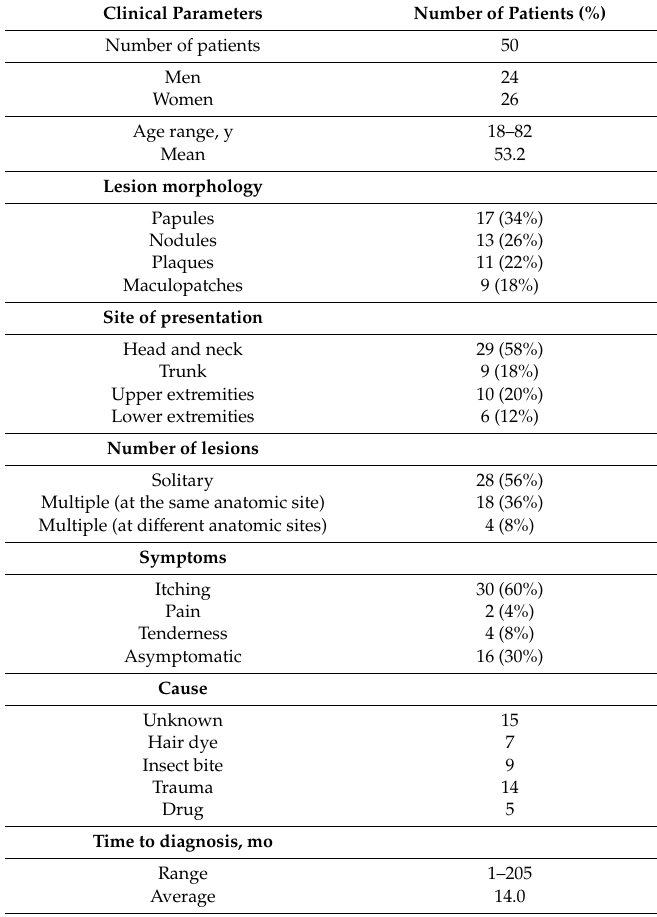
Table 1. Clinical features and causes of cutaneous lymphoid